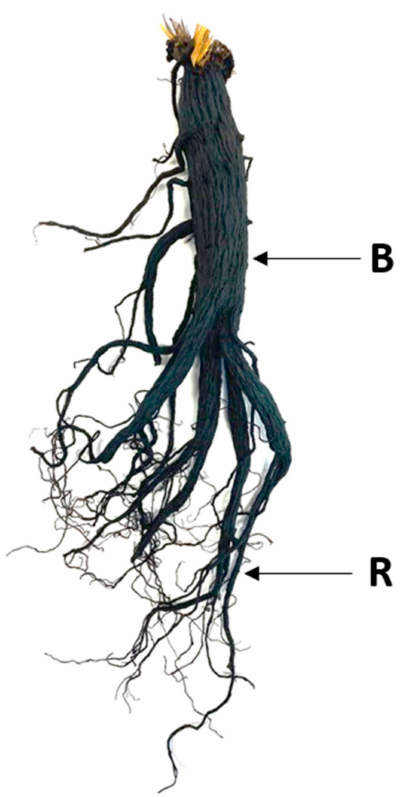
Figure 5. Classification of black ginseng root. ; B: Main root; R: Fine